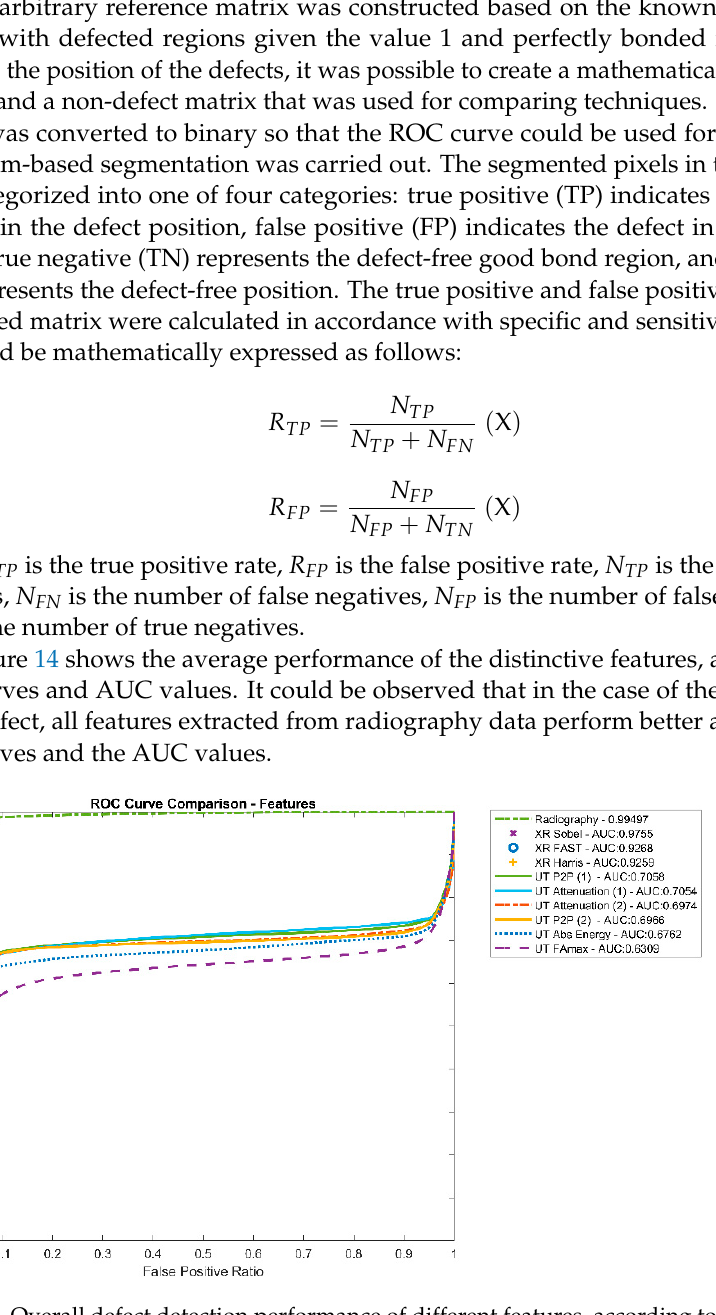
Figure 14. Overall defect detection performance of different features, according to ROC curves and AUC values.